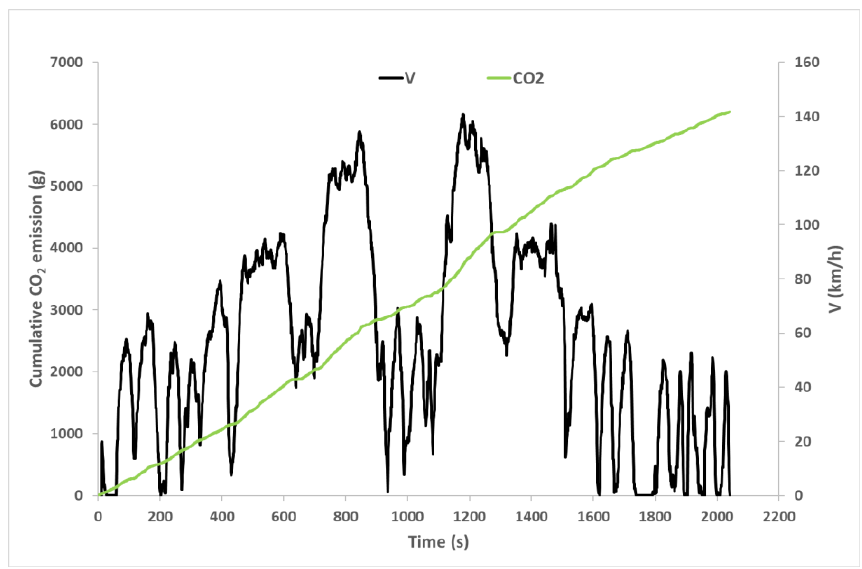
Figure 17. Cumulative CO 2 emission versus vehicle speed in on-road test, CNG propulsion.